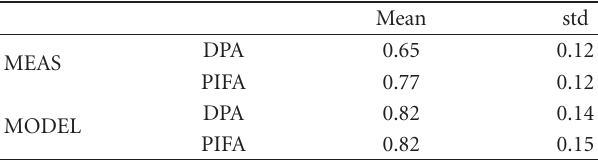
Table 4: The mean value and standard deviation of eigenvalue dispersion.